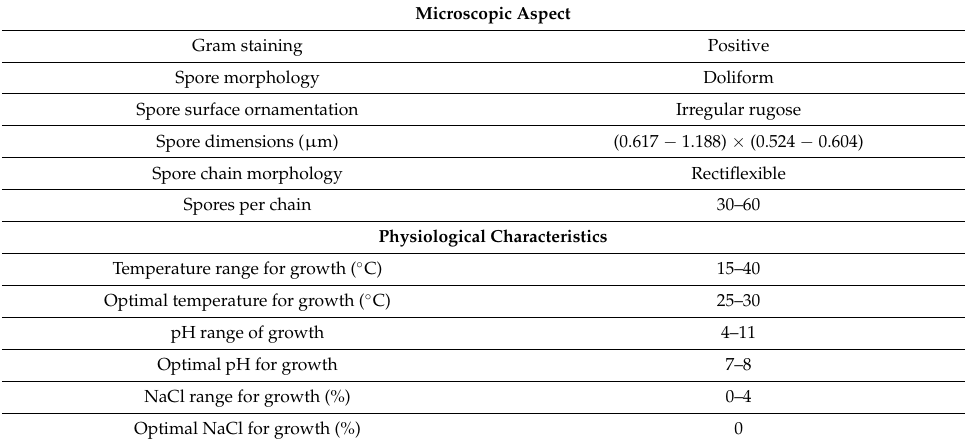
Table 2. Characteristics of the Streptomyces sp. ADR1